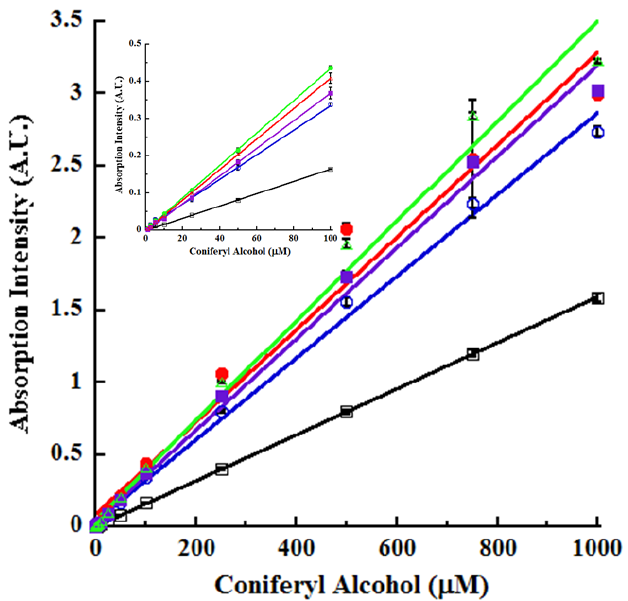
Figure 2. Sensitivity of unmodified CA detection. Increasing and indicated concentrations of unmodified CA (100 μ L) were dispensed in 96-well UV-transparent microplate. Absorption from CA was measured under the following reaction conditions: pH 4.5, 228 nm (open circles; blue); pH 4.5, 260 nm (closed circles; red); pH 4.5, 295 nm (open squares; black); 250 mM KOH, 228 nm (closed squares; purple); and 250mM KOH, 295 nm (open triangles; green). The linearity values of the correlation of coefficients ( r 2 ) for the various tracings are provided in Table 1. The inset shows the 0 to 100 μ M CA dose-response tracings. All other conditions were as in Figure